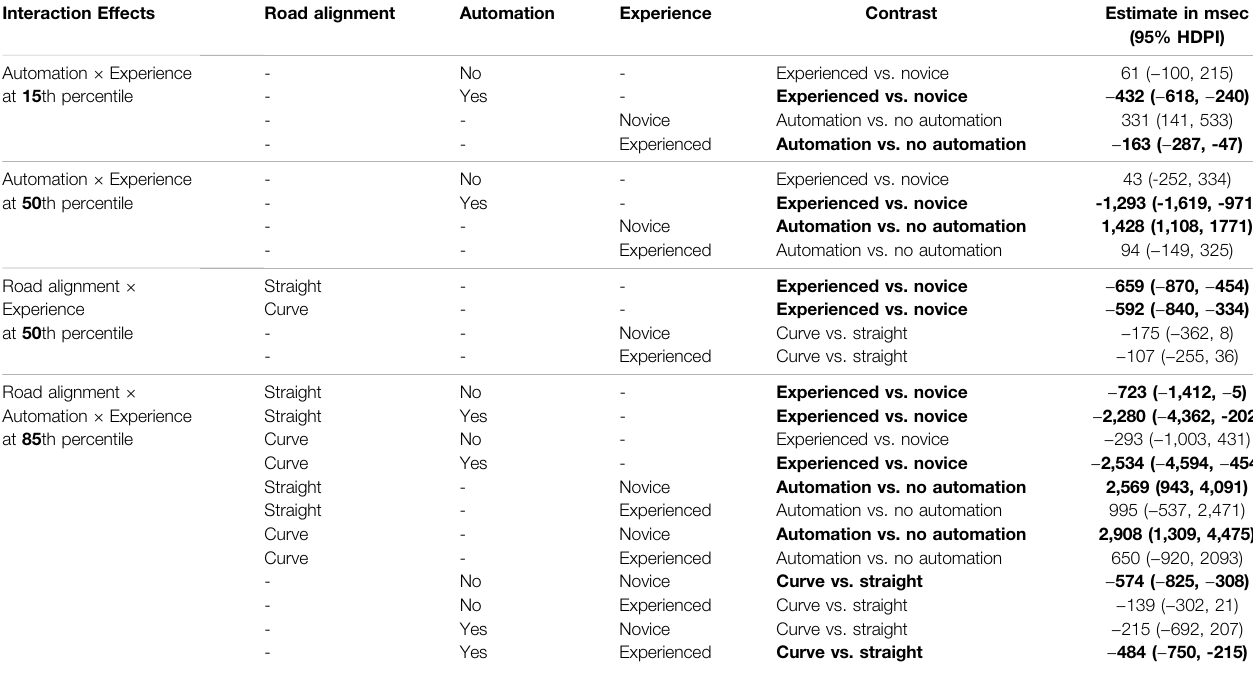
TABLE 3 | Post-hoc contrasts for signi fi cant main and interaction effects; signi fi cant ( p < 0.05) fi ndings are bolded; HPDI: highest posterior density interval. Interaction Effects Road alignment